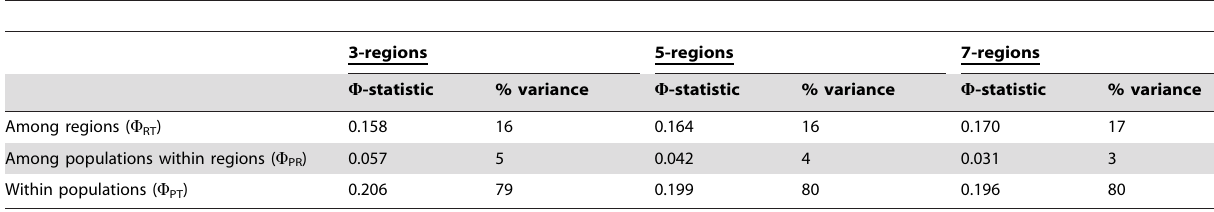
Table 3. Hierarchical AMOVA results for biogeographically relevant groups among 17 collections of shortnose sturgeon ( Acipenser brevirostrum ) surveyed at 11 polysomic microsatellite DNA